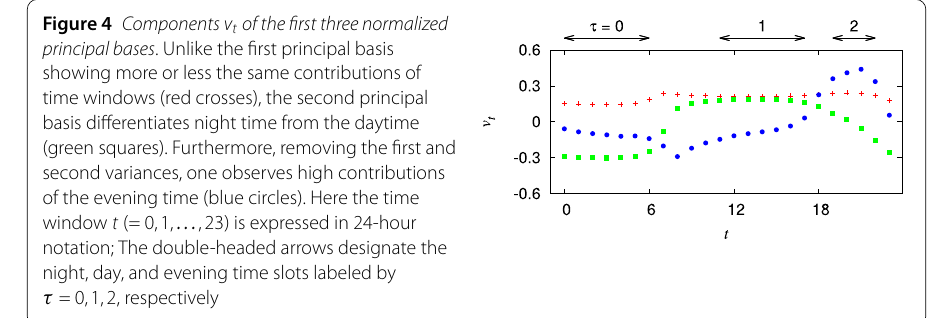
Figure 4 Components v t ofthefirstthreenormalized principalbases . Unlike the first principal basis showing more or less the same contributions of time windows (red crosses), the second principal basis differentiates night time from the daytime (green squares). Furthermore, removing the first and second variances, one observes high contributions of the evening time (blue circles). Here the time window t (= 0,1, ... ,23) is expressed in 24-hour notation; The double-headed arrows designate the night, day, and evening time slots labeled by τ = 0,1,2, respectively